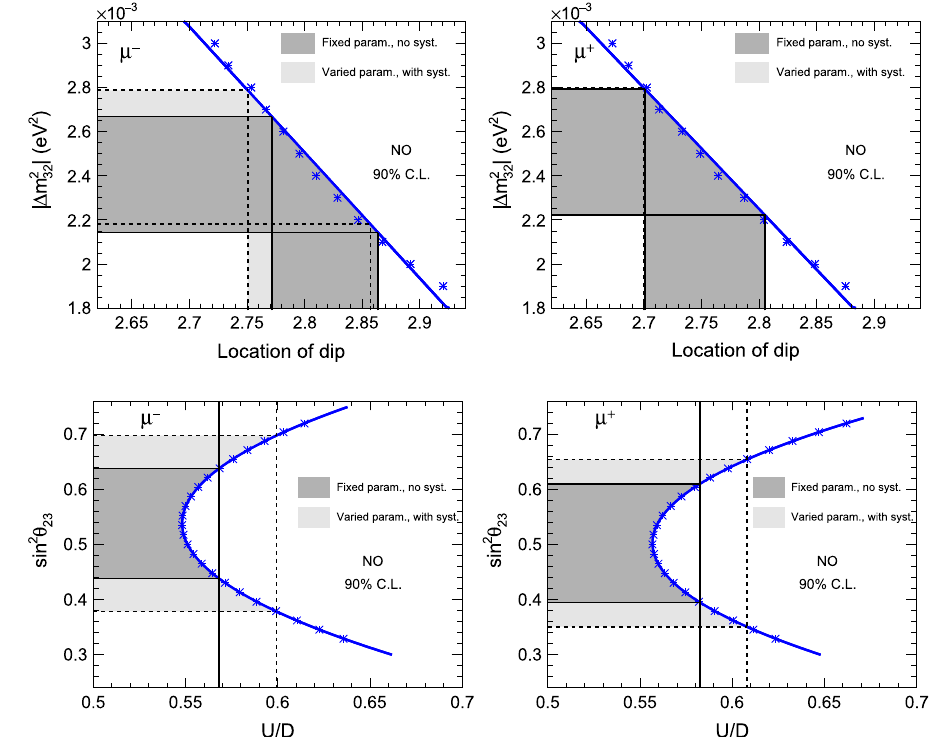
Fig. 6 Upper panels: the blue points and the blue line correspond to allowed ranges of the U/D ratio, and hence the inferred sin 2 θ 23 through | with the location of the dip, obtained the calibration of actual | (cid:3) m 2 calibration, for sin 2 θ 23 ( true ) = 0 . 5, with (without) systematic errors 32 by using the 1000-year MC data sample. The light (dark) gray bands and uncertainties in the other oscillation parameters. For all the confi- represent the 90% C.L. regions of the location of the dip, and hence the dence regions, we use 10 years exposure of ICAL. The results obtained | through calibration, for | (cid:3) m 2 | ( true ) = 2 . 46 × 10 − 3 inferred | (cid:3) m 2 from μ − and μ + events are shown in left and right panels, respec- 32 32 tively. For the fixed-parameter analysis, we use the benchmark oscilla- eV 2 , with (without) systematic errors and uncertainties in the other tion parameters given in Table 1, while for the inclusion of systematic oscillation parameters. Lower panels: The blue points and the blue line uncertainties and variation of oscillation parameters, we use the proce- correspond to the calibration of actual sin 2 θ 23 with the total U/D ratio dure described in Sect. across all bins. The light (dark) gray bands represent the 90% C.L.